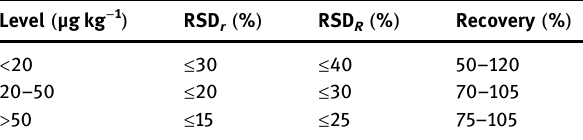
Table 2: Analytical method criteria for patulin